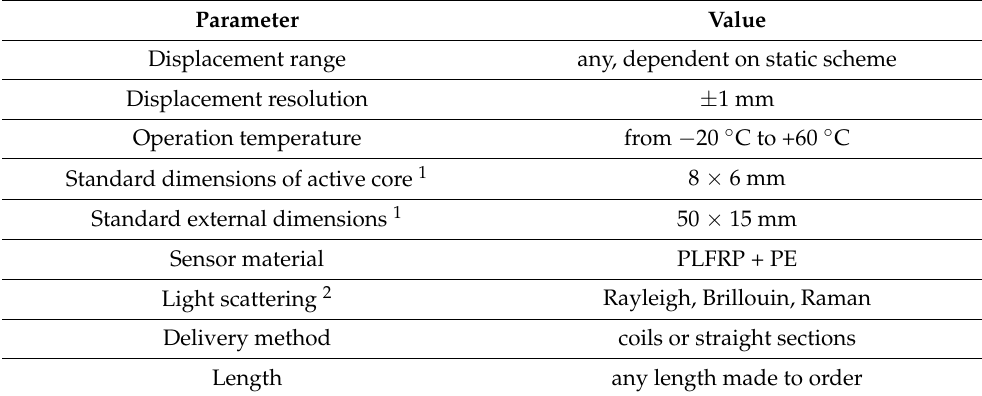
Table 5. Technical specifications of distributed fibre optic displacement 3DSensor